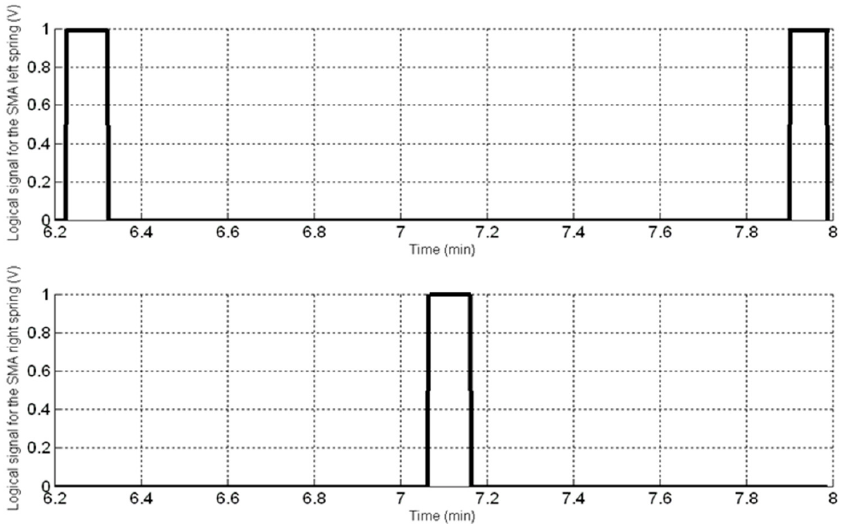
Figure 14. Logical signals to drive the power suppliers.